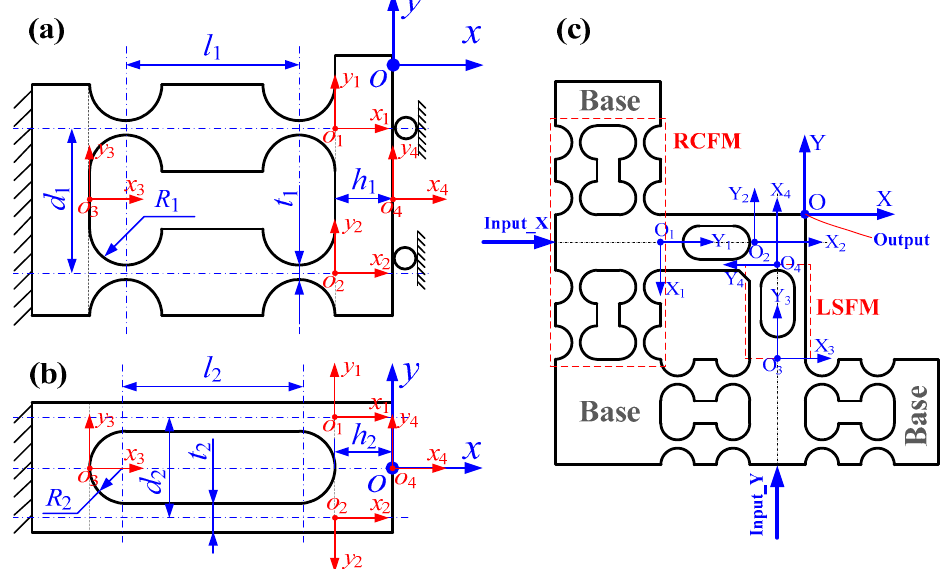
Figure 3. Schematic diagram of the MCM method for the 2-DOF pseudo-decoupled compliant mechanism (PDCM). ( a ) Right circular flexure module (RCFM), ( b ) Leaf-spring flexure module (LSFM), ( c ) 2-DOF PDCM .